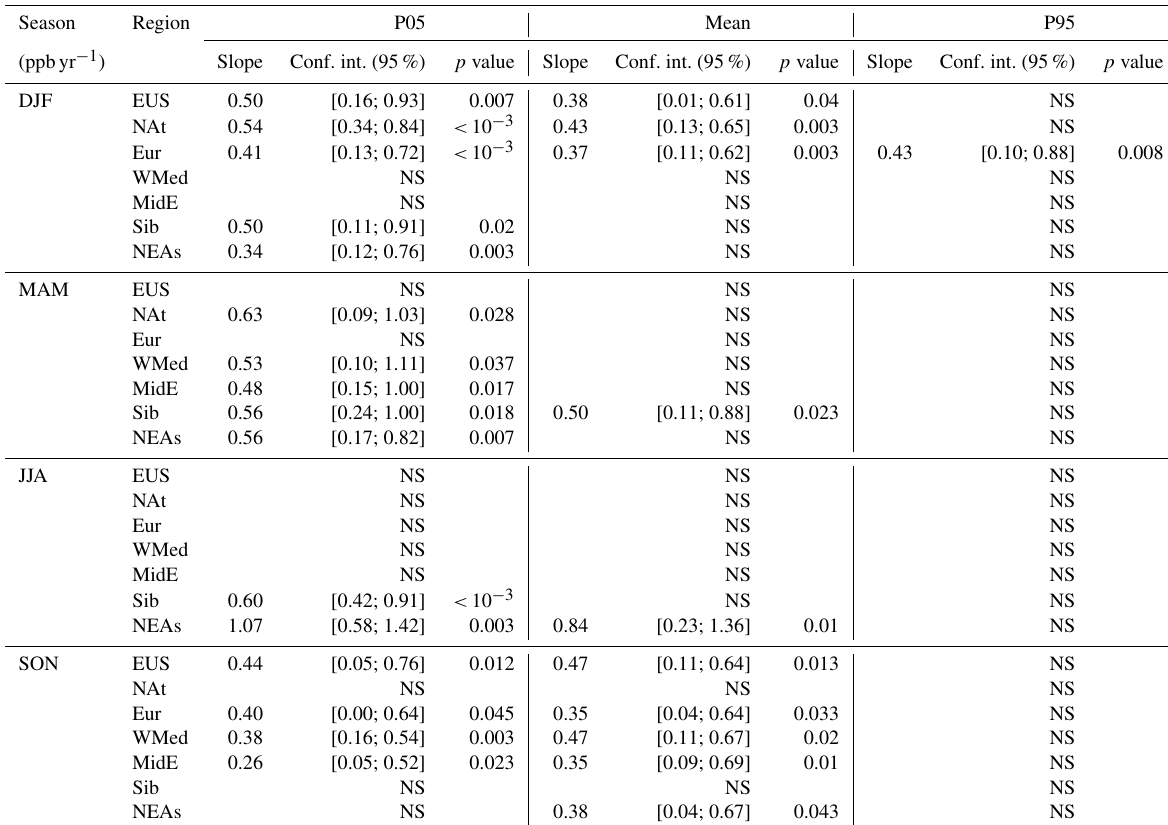
Table D2. O 3 absolute trends in ppbyr − 1 during each season in the UT. From left to right, the anomalies are taken from deseasonalized P05, monthly means, and P95. The insignificant trends with respect to the 95% confidence level are indicated as